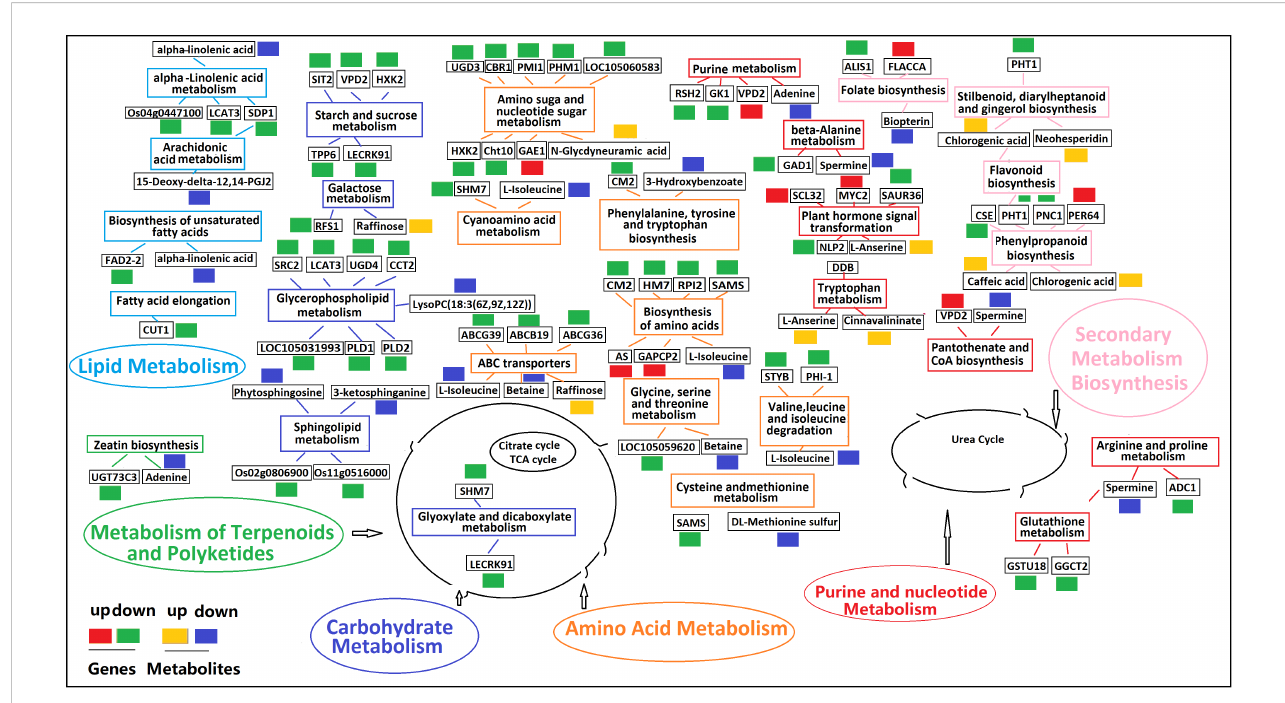
FIGURE 11 Pro fi les of DEGs and DAMs in fl avonoid biosynthetic pathways in K 0 vs. K ck . The boxes in the pathway represent DEGs or DAMs. Red and green represent up- and down-regulated genes, respectively. Yellow and blue represent up- and down-regulated metabolites, respectively. Boxes of the same color represent the relevant